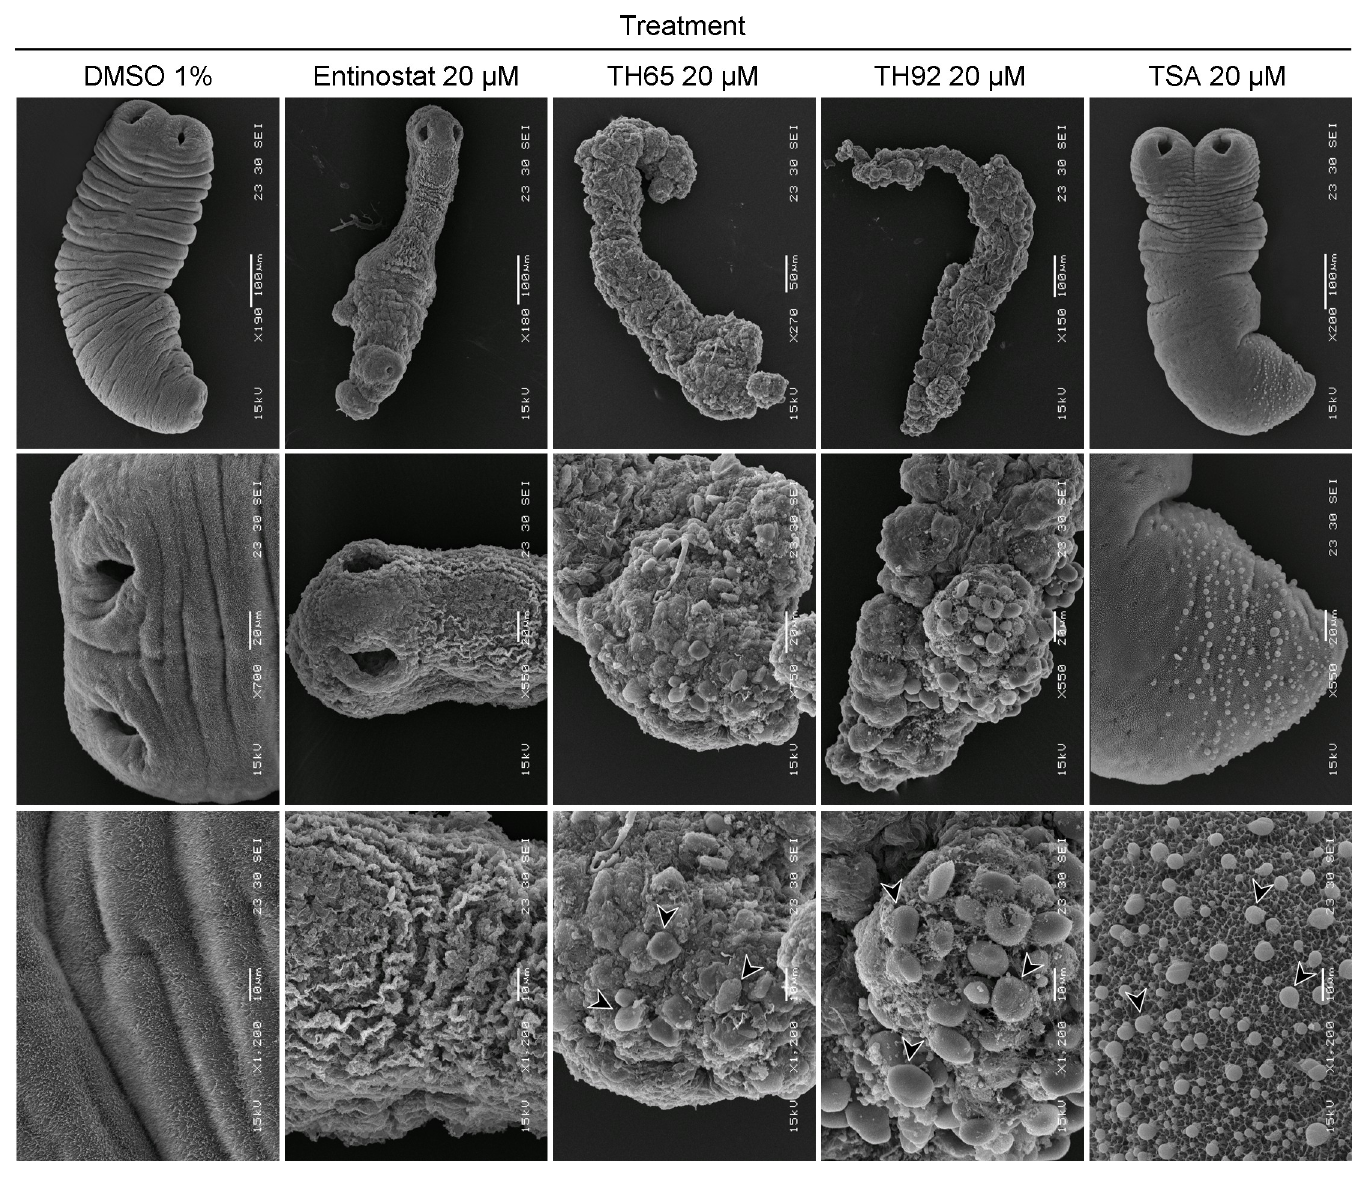
Fig 5. Effect in parasite morphology of selected HDAC inhibitors and trichostatin A (TSA). Scanning electron microscopy images of Mesocestoides vogae tetrathyridia (TTy) treated with the individual HDAC inhibitors -entinostat, TH65, and TH92- or the pan-HDAC inhibitor TSA at 20 μ M after 6 days of incubation and at different magnifications (indicated in each figure). Extensive damage was observed on M . vogae TTy treated with the HDAC inhibitors, with marked alterations on the tegument and a disintegration of parasite morphology, as well as a significant number of vesicle-like structures of different sizes on the tegument (arrows) and a complete loss of microtriches. The sizes of the scale bars are shown in each image. TTy incubated with the drug vehicle 1% DMSO were used as a negative